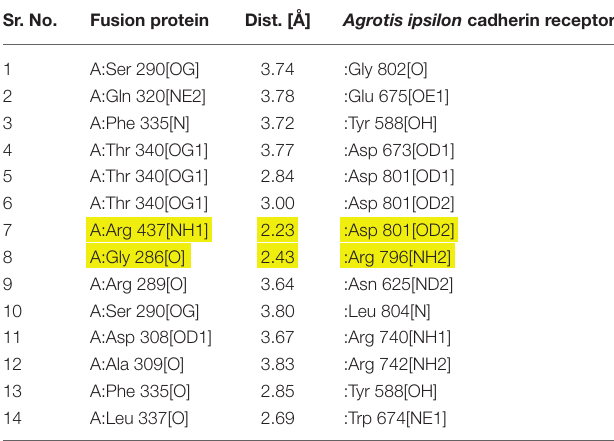
TABLE 2 | Interaction of fusion protein with Agrotis ipsilon cadherin receptor. Sr. No.